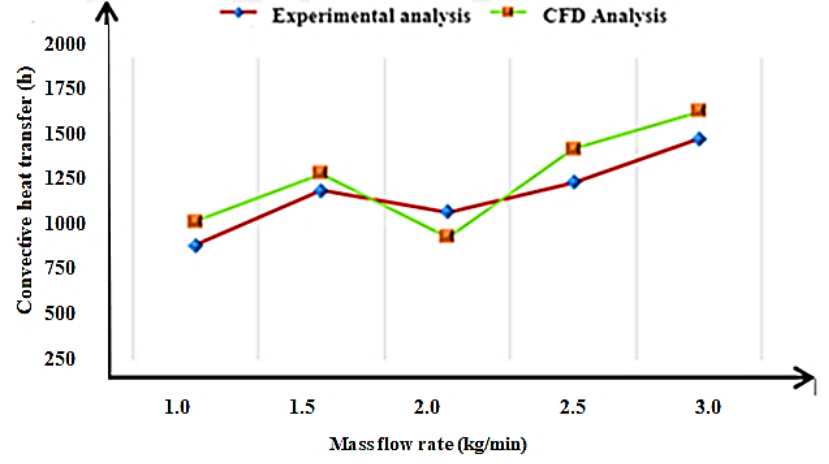
Figure 9. Convective heat Figure 9 . Convective heat transfer. Figure 9 . Convective heat transfer.